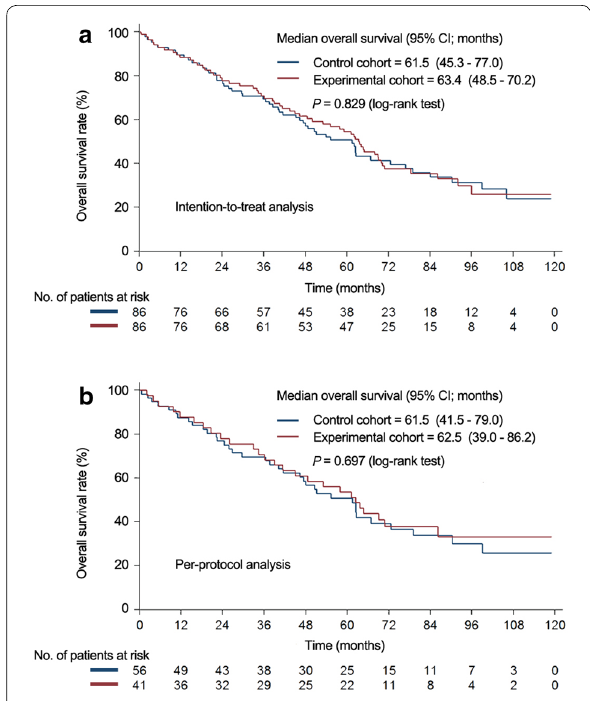
Fig. 3 Comparison of overall survival by intention‑to‑treat ( a ) or per‑ protocol ( b ) analyses. CI confidence